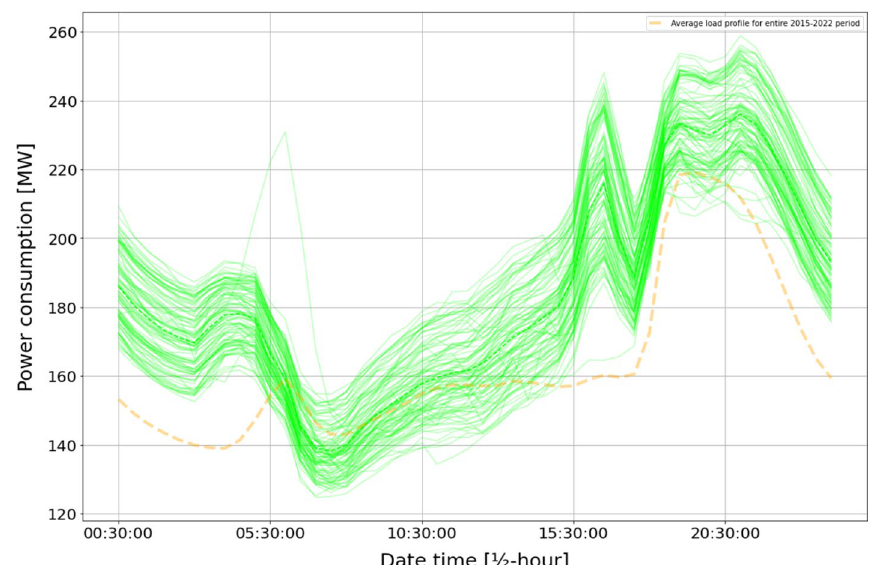
Fig. 13 Electricity load profiles in cluster 3 (100 samples from the 2015–2022 dataset)